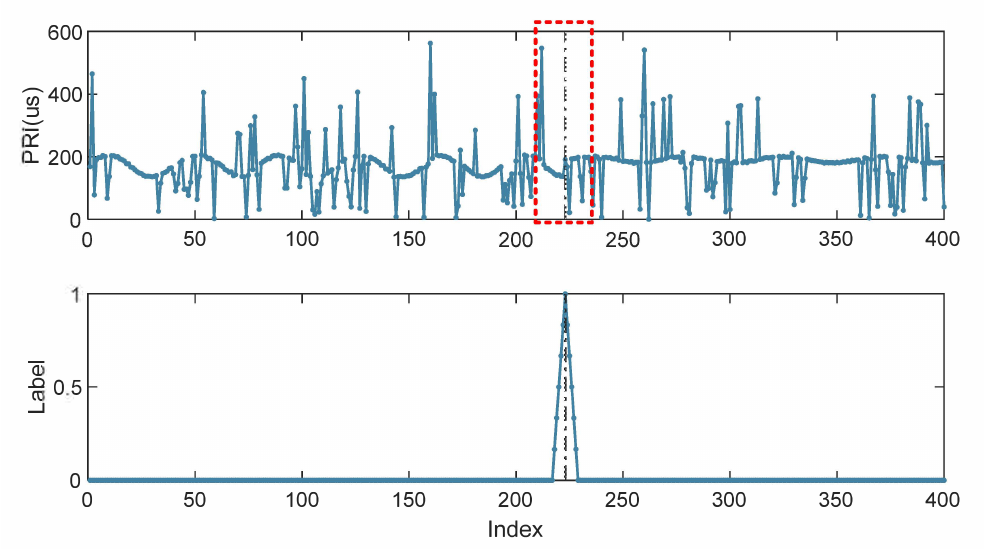
Figure 5. Example of the change point in a noisy periodic PRI sequence ( first row ). Both the dynamic trend and noise makes it difficult to establish the exact location of the change point, which can be identified within the red dashed box region. The corresponding label designed as a linear centered smoothing margin in the change point ( second row